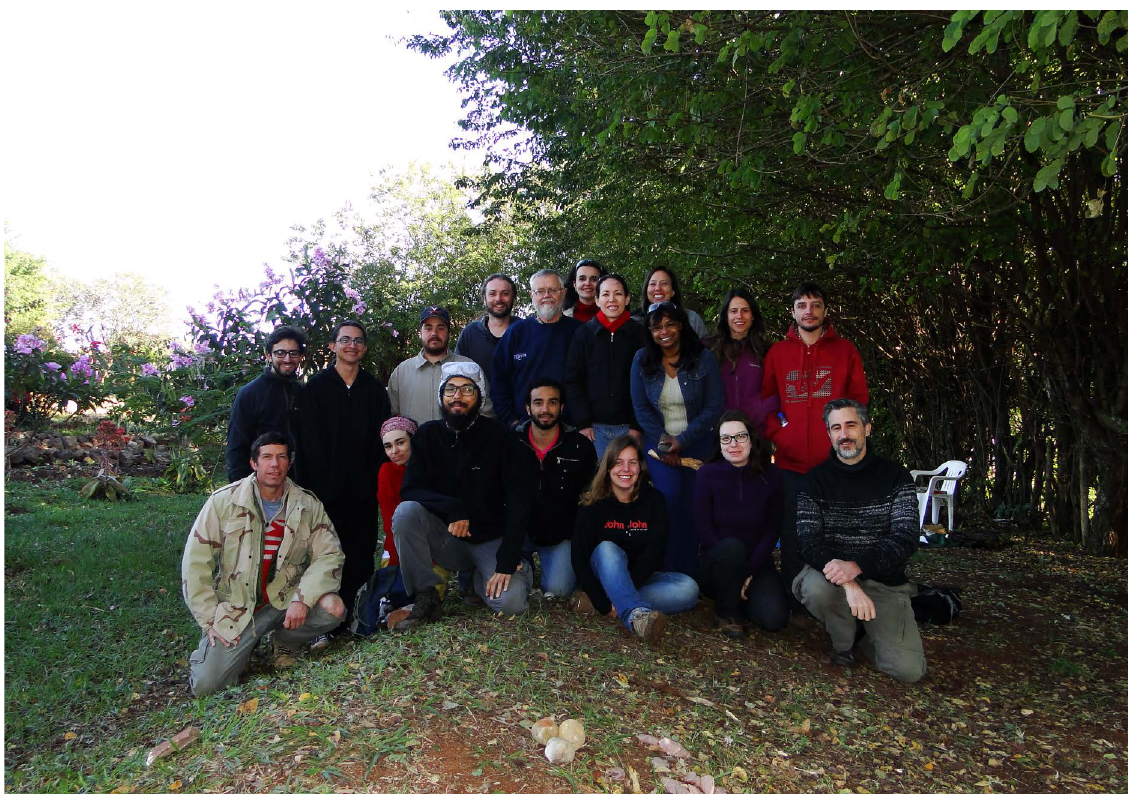
Figure 1. The Participants and organizers of the workshop. (Photograph by Astolfo G. M. Araujo, 2016.)